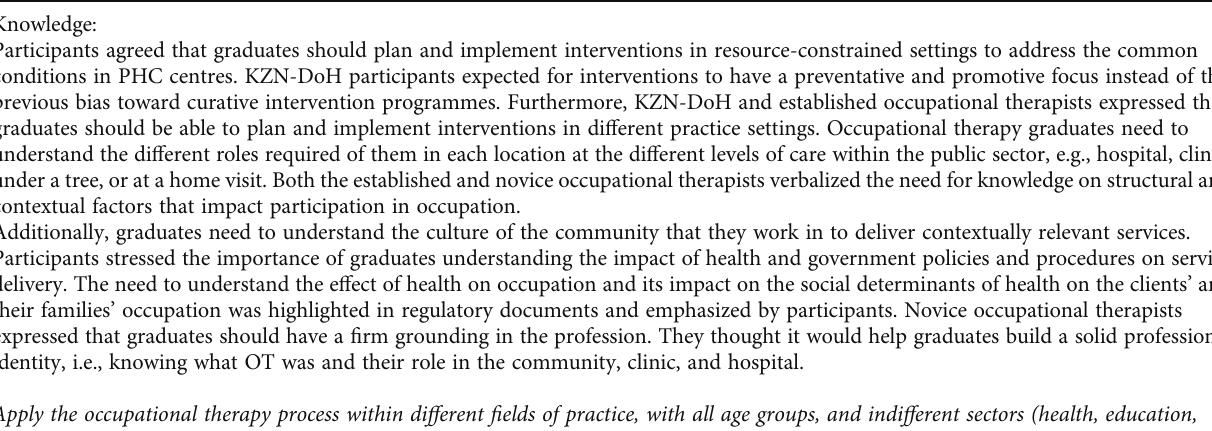
Table 2: Theme 1: role of a health